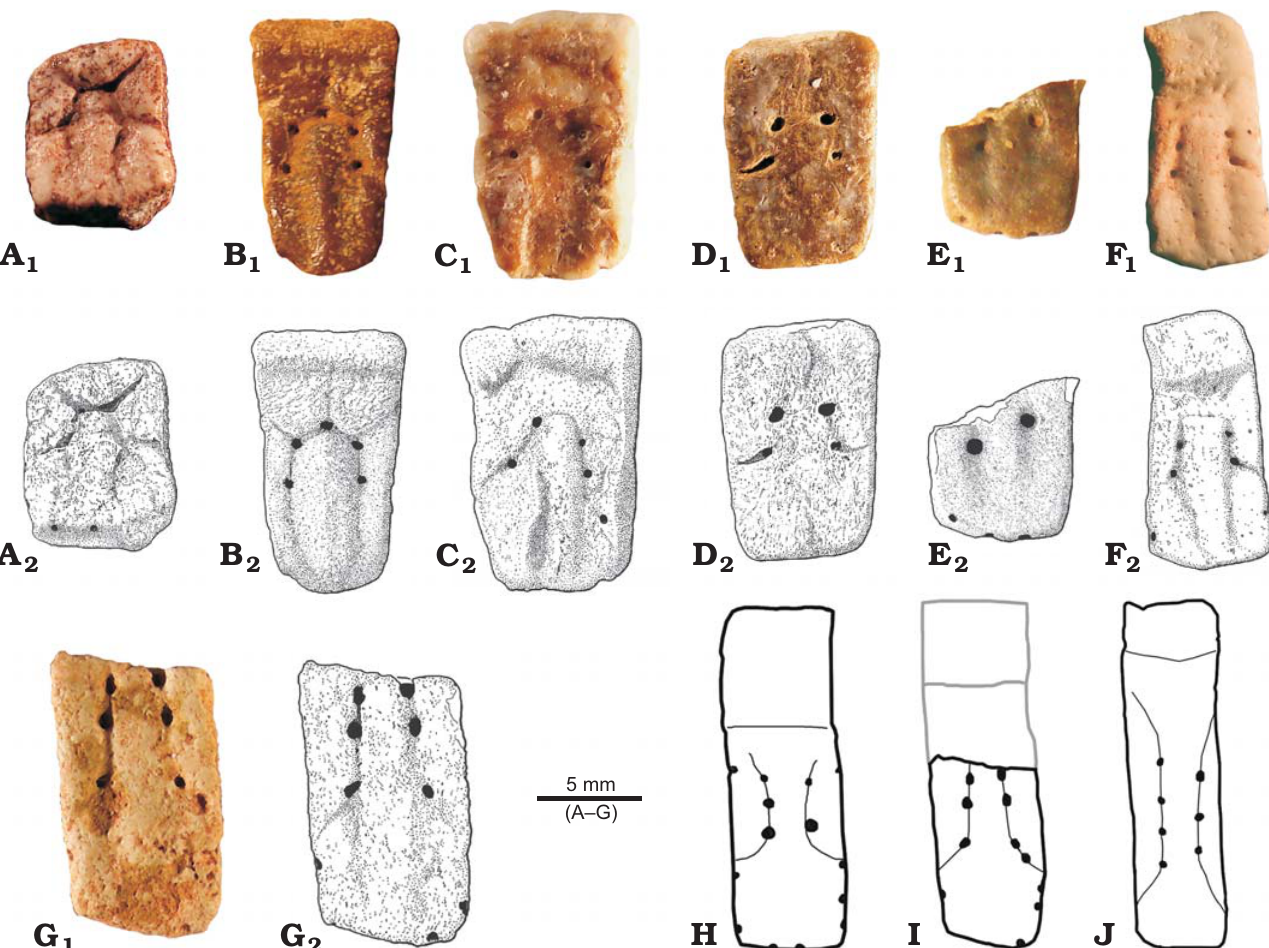
Fig. 4. Dasypodines from the middle member of the Geste Formation, middle–late Eocene, Northwestern Argentina. A . cf. Astegotherium sp., fixed osteo- derm, MHAS 067; Quebrada El Paso, near the Pozuelos salt flat, Los Andes Department, Salta Province. B , C .? Prostegotherium sp., movable osteoderms, MHAS 024 ( B ) and PVL 6567 ( C ); Antofagasta de la Sierra, Catamarca Province. D − F . Parastegosimpsonia cf. P. peruana , fixed osteoderms, PVL 6569 ( D ) and MLP 88-V-10-19A ( E , broken); movable osteoderm, PVL 6409 ( F ); Antofagasta de la Sierra, Catamarca Province. G . Dasypodinae indet., mov- able osteoderm, MLP 88-V-10-19; Antofagasta de la Sierra, Catamarca Province. H − J . Movable osteoderms of Stegosimpsonia ( H ), Dasypodinae